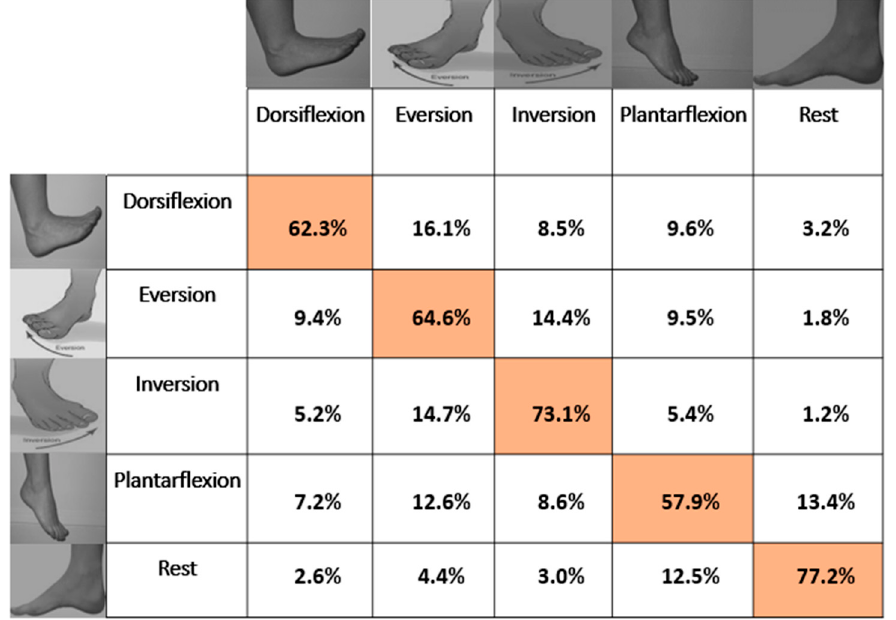
Figure 6. Confusion matrix based on the average classification accuracies of all subjects for ANN with overall average accuracy of 67.1% ± 7.9%. The Highlighted boxes represents the correct percentage of predictions made by the classifier.